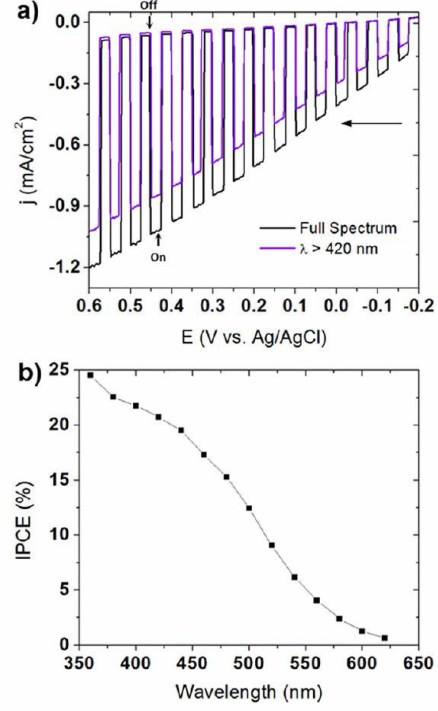
Figure 13. ( a ) Linear sweep voltammetry plot using a three-electrode configuration in 0.25 M NaI/acetonitrile with and without a 420 nm cut-on filter for an optimized BiOI film deposited at 533 K. The anodic scan rate was 25 mV s − 1 . ( b ) IPCE spectrum recorded at 0.4 V vs. Ag/AgCl for a typical BiOI film deposited at 533 K with a peak light intensity of 476 µ W cm − 2 . Reproduced with permission from [166]. Copyright American Chemical Society,